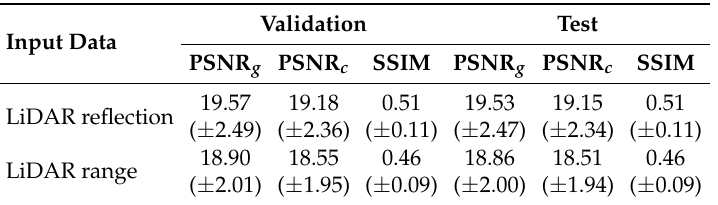
Table 1. Generated image quality performance using single-input-based color-image-generation deviation is listed in parenthesis.